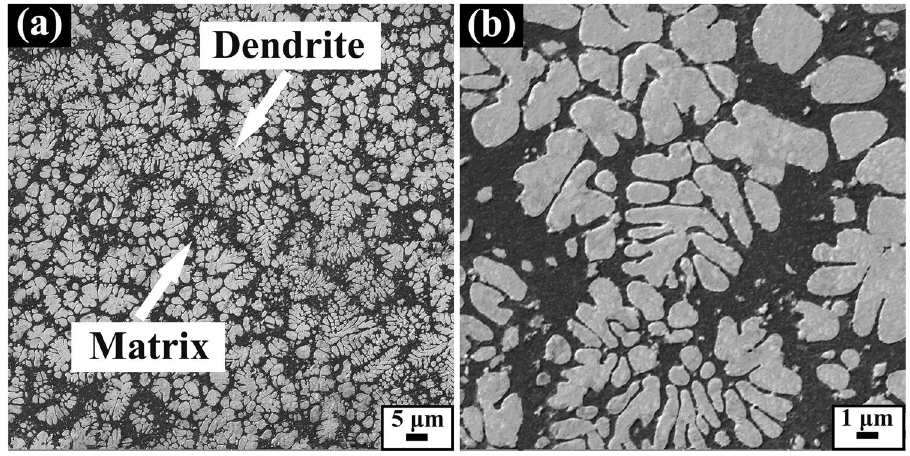
Figure 1. ( a ) Low and ( b ) high magnification SEM images of the present